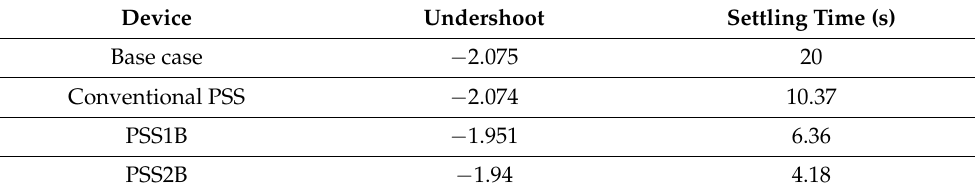
Table 15. Maximum overshoot and settling time of rotor angle deviation at heavy loading.